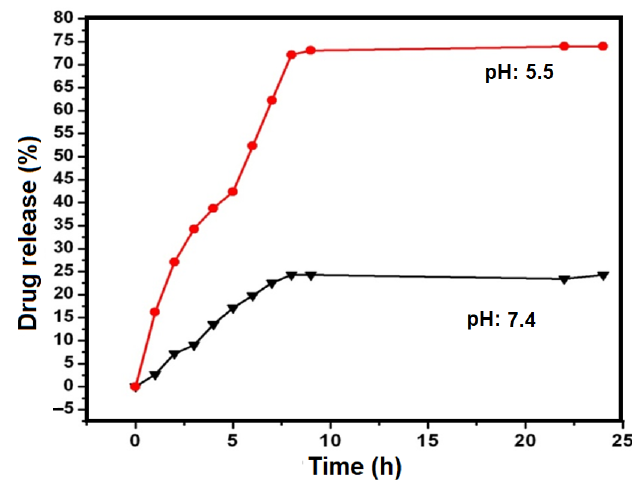
Figure 5. Drug release percentage of CHL-GO composite with time at different pH values.